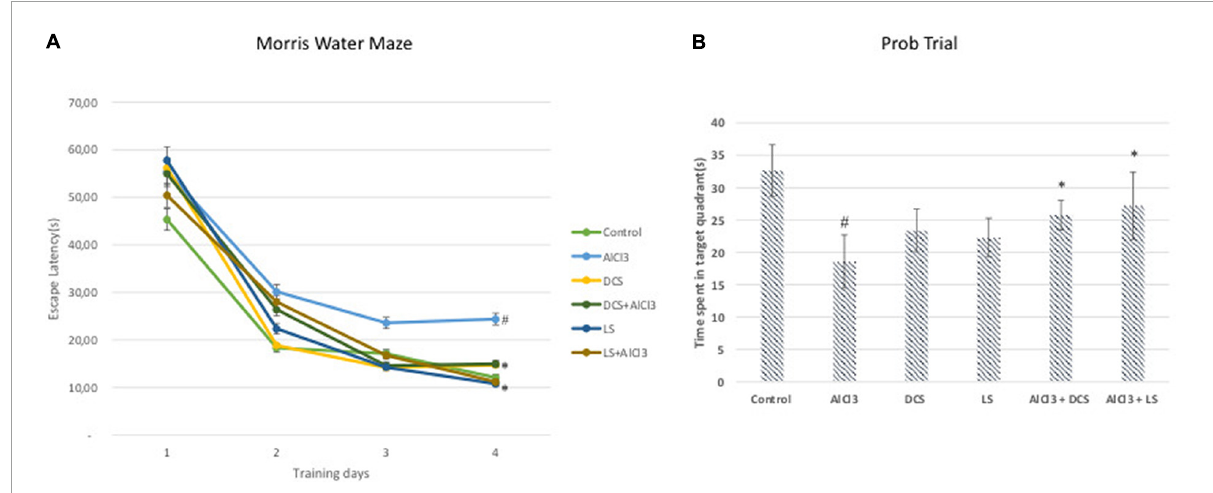
FIGURE2 (A) Escape latency in the MWM test of each training day. (B) Mean time spent in the target quadrant in the MWM test. The behavioral analysis (A,B) was compared to the control group. Significance difference between groups indicated by: # between control and AlCL 3 , * between AlCl 3 and treatment